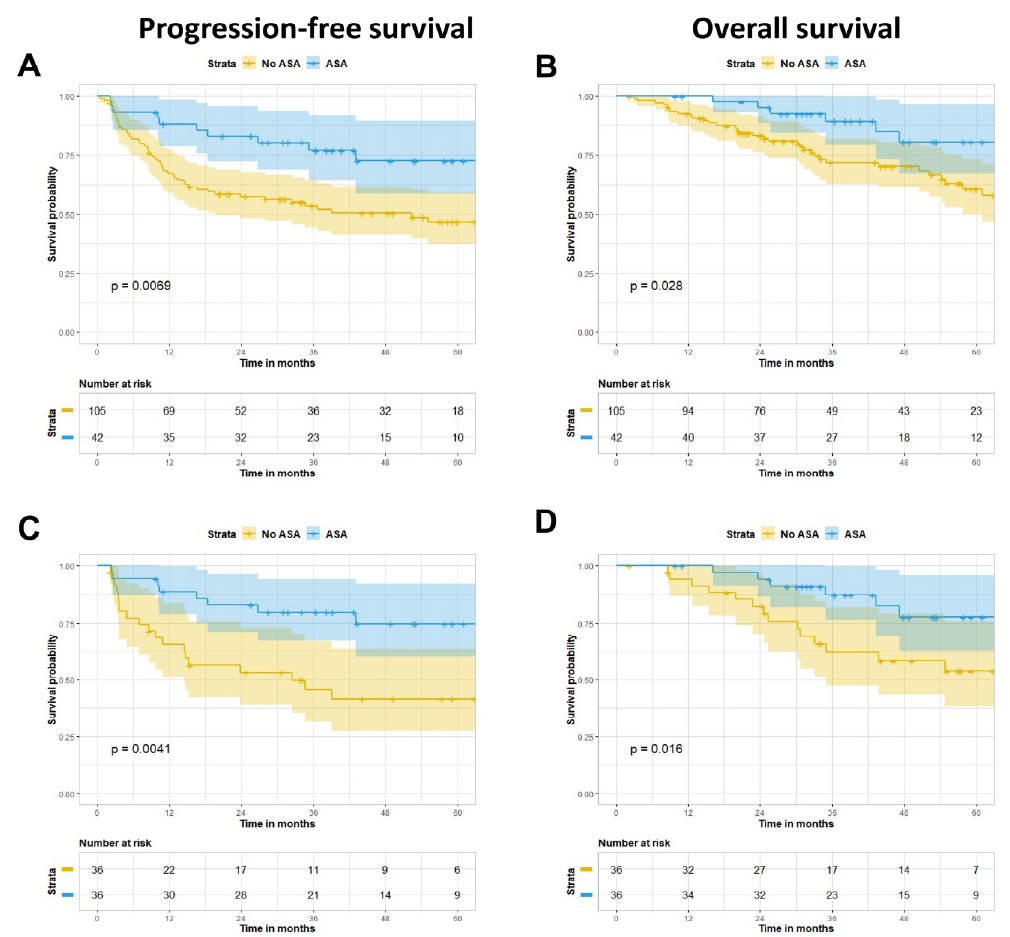
Figure 1. Kaplan-Meier survival estimates and 95% confidence intervals in the unmatched ( n = 147) and matched ( n = 72) cohorts for relapse-free survival ( A , C ) and overall survival ( B , D ),